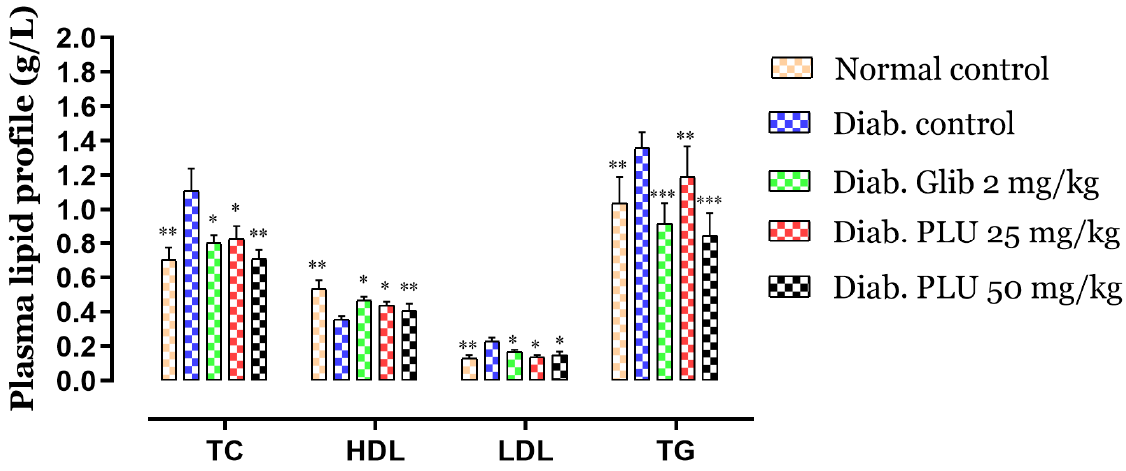
Figure 2. Effects of PLU on plasma lipid profiles. Values are represented as means ± SD ( n = 5 mice). *** p < 0.001, ** p < 0.01, and * p < 0.05 compared to diabetic controls.